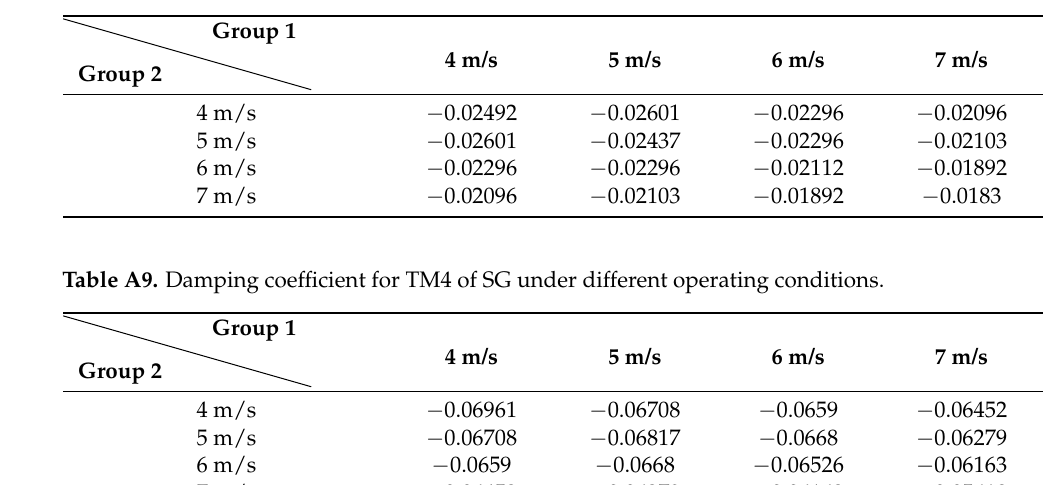
Table A8. Damping coefficient for TM3 of SG under different operating conditions.